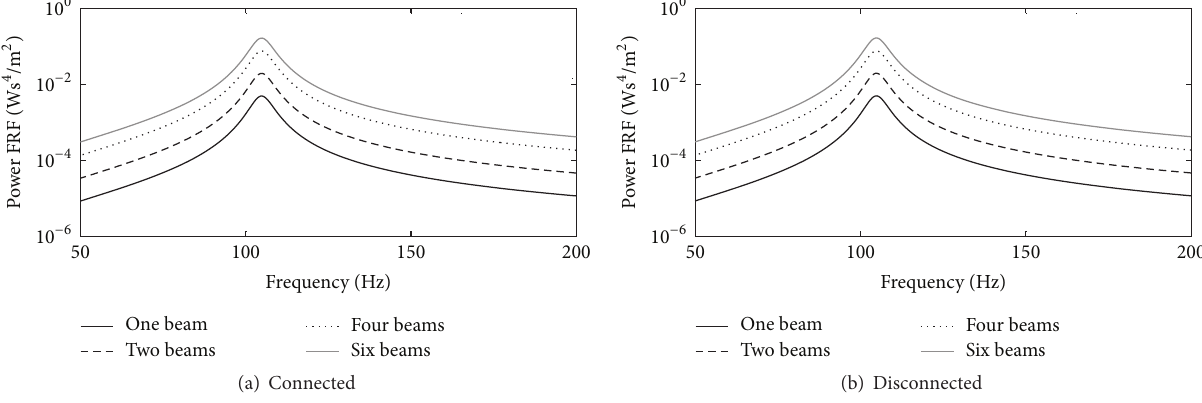
Figure 6: Power FRF with an increasing number of identical bimorph beams, 𝑀 𝑡,𝑖=1,...,6 = 0.3𝑚𝐿 and 𝑘 𝑖=1,...,5 = 0.3𝑌𝐼/𝐿 3 .